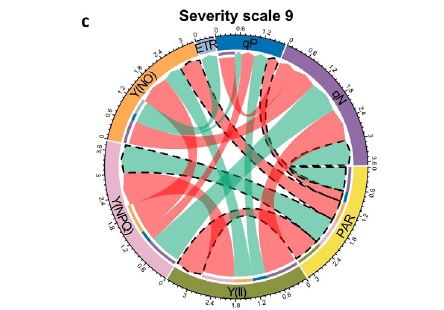
Figure 7. Correlation coefficients between chlorophyll fluorescence (Chl a ) variables as photosynthetically active radiation (PAR) increases to show the disruption in the function of the photosynthetic apparatus with an increase in disease severity scales of web blight. Results are shown as: ( a ) the heat map of the Pearson correlation coefficients between a PAR increase and fluorescence variables for each severity scale. The color gradient from green to red indicates the magnitude of positive to negative correlation. *** represent significant at probability level of 0.001. The circles correspond to the chord diagram of the correlation coefficients between PAR increase and fluorescence variables; ( b ) severity scale 1, “no visible symptoms;” and ( c ) severity scale 9, “very severe disease symptoms.” Ribbons inside the circle correspond to significant correlations with a p -value < 0.05; green ribbons indicate positive coefficients, and red ribbons indicate negative coefficients.